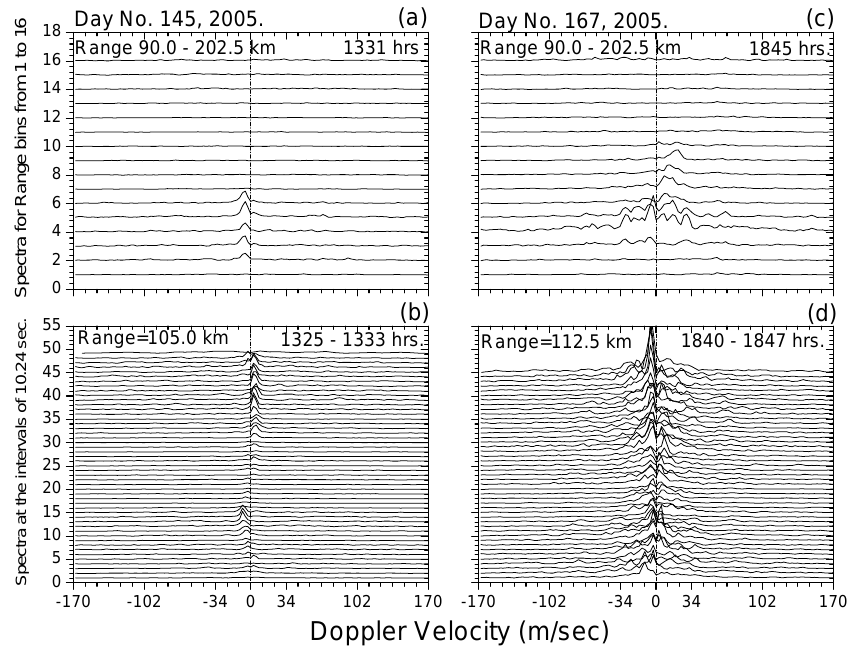
Fig. 1. (a) Spectra of the signals received in the 16 range bins for day no. 145, 2005 (25 May 2005), (b) Doppler spectra of E S echo in range bin 3 (range 105km) at successive intervals of 10.24s, (c) is similar to (a) except for day no. 167, 2005 (14 June 2005)and (d) is similar to (b) except for day no. 167, 2005 and range bin 4 (range 112.5km). Positive velocities indicate upward motion and negative velocities indicate downward